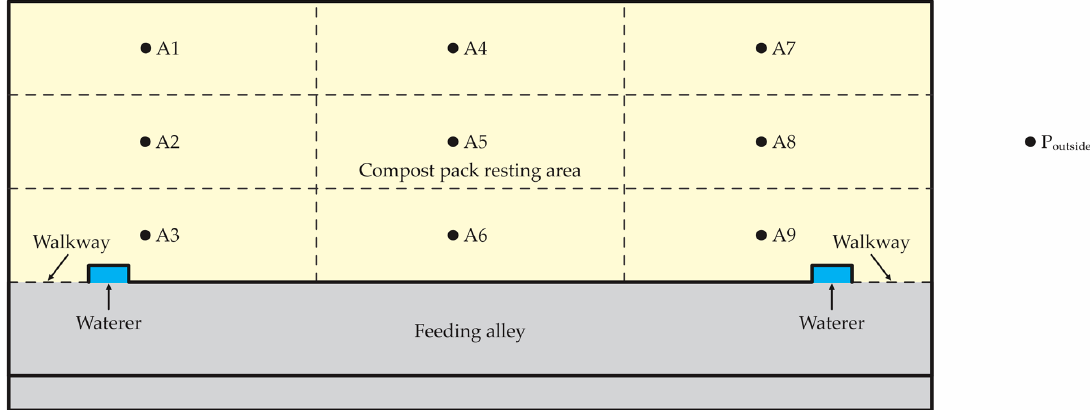
Figure 2. Nine grid spaces (A1–A9) and one outside point (P outside ) of environmental measurements and sample collections inside of the barns. and sample collections inside of the